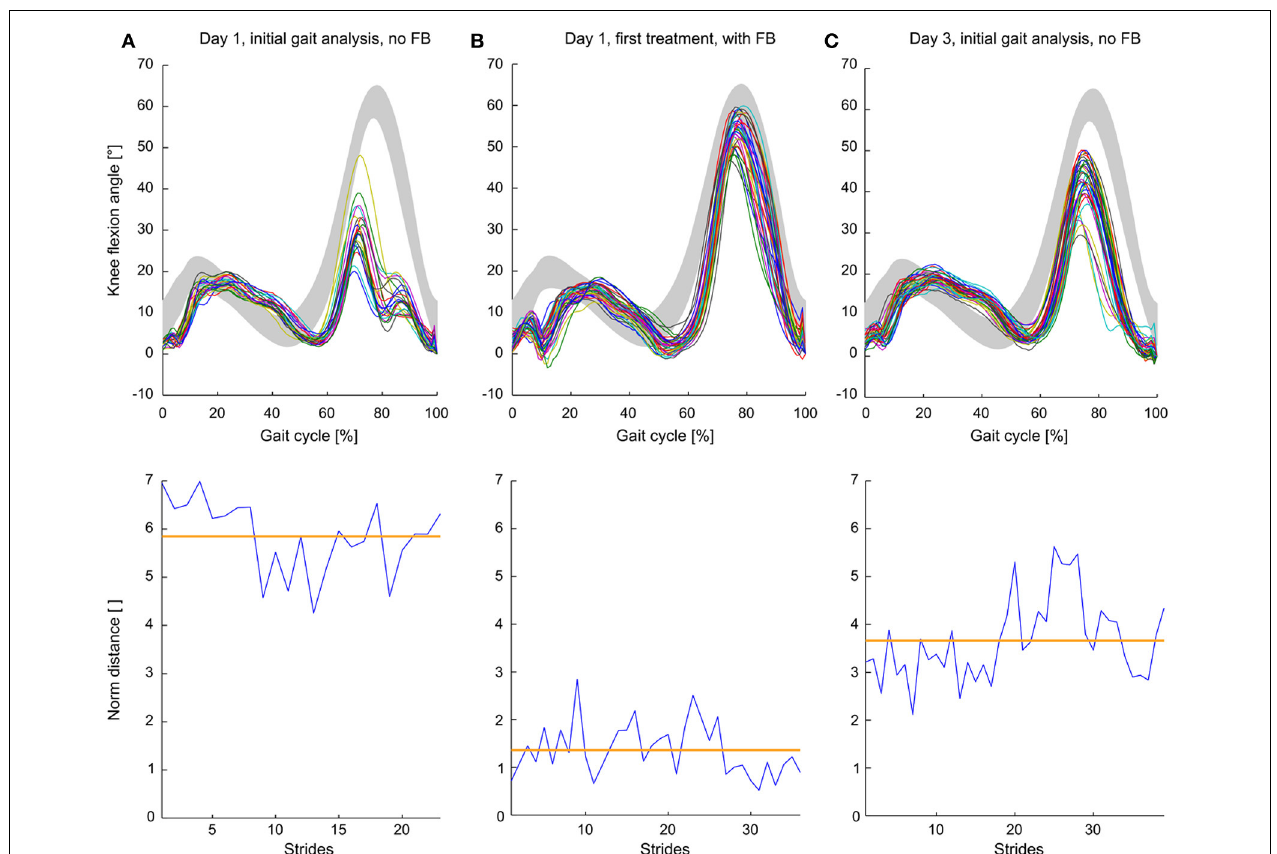
FIGURE 7 | Step normalized knee angle curves and norm distance values of a single individual with iSCI during (A) initial gait analysis (no feedback) on day 1, (B) first feedback trial during the first day of training